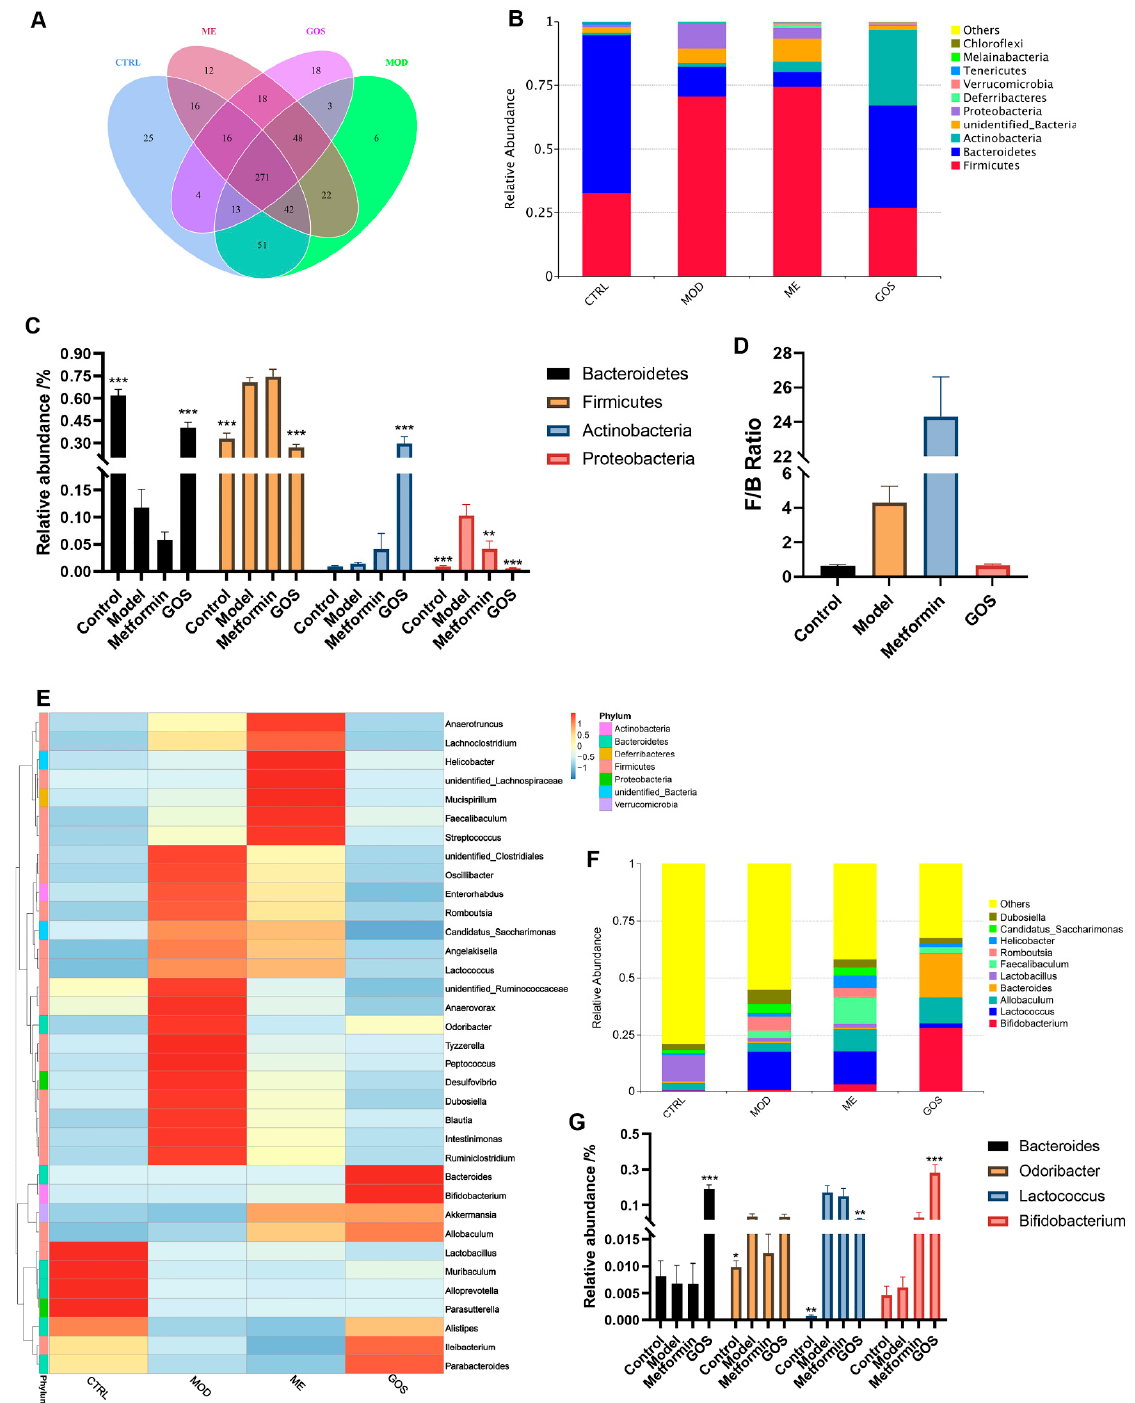
Figure 8. ( A ) Venn diagram of OTUs sequence of stool sample. ( B ) Relative abundance of species at the bacteria Phylum level. ( C ) The relative abundance statistics of the largest species in each group after administration at the bacteria Phylum level. ( D ) The effect of GOS on the relative abundance ratio of Firmicutes and Bacteroides. ( E ) Heat map of relative abundance of different metabolites in each group at the bacteria Phylum level. ( F ) Relative abundance of species at the bacteria genus level. ( G ) The relative abundance statistics of the largest species in each group after administration at the bacteria genus level. Note: * p < 0.05, ** p < 0.01, *** p < 0.001 vs. the model group ( n = 4–5, mean ±